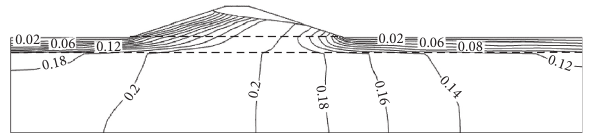
Figure 5: Contour map of the standard deviation of the total head.